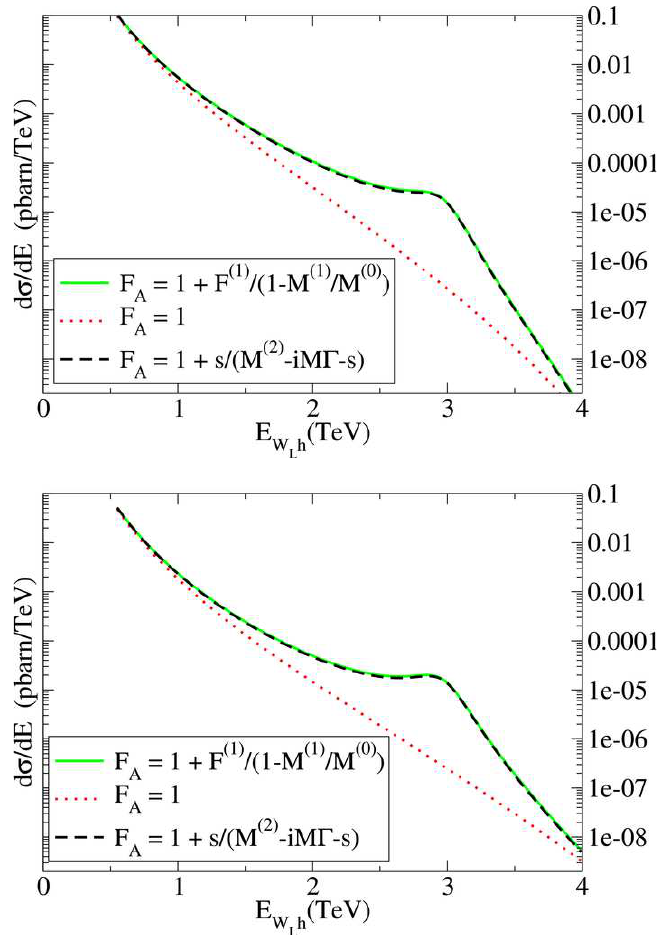
Figure 6 . Production cross section of W ± L h pairs with (top solid green and dashed black lines) and without (bottom dotted red line) a 3 TeV axial-vector resonance. The cross-section is enhanced by the latter, in this case by over an order of magnitude. The top plot corresponds to W + h and the bottom one to W − h ; they are almost equal near the peak, with the positively charged